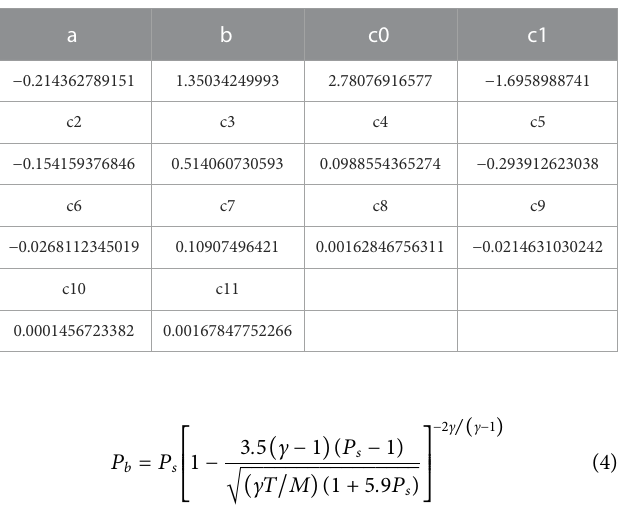
TABLE 1 Function parameters for Eq.